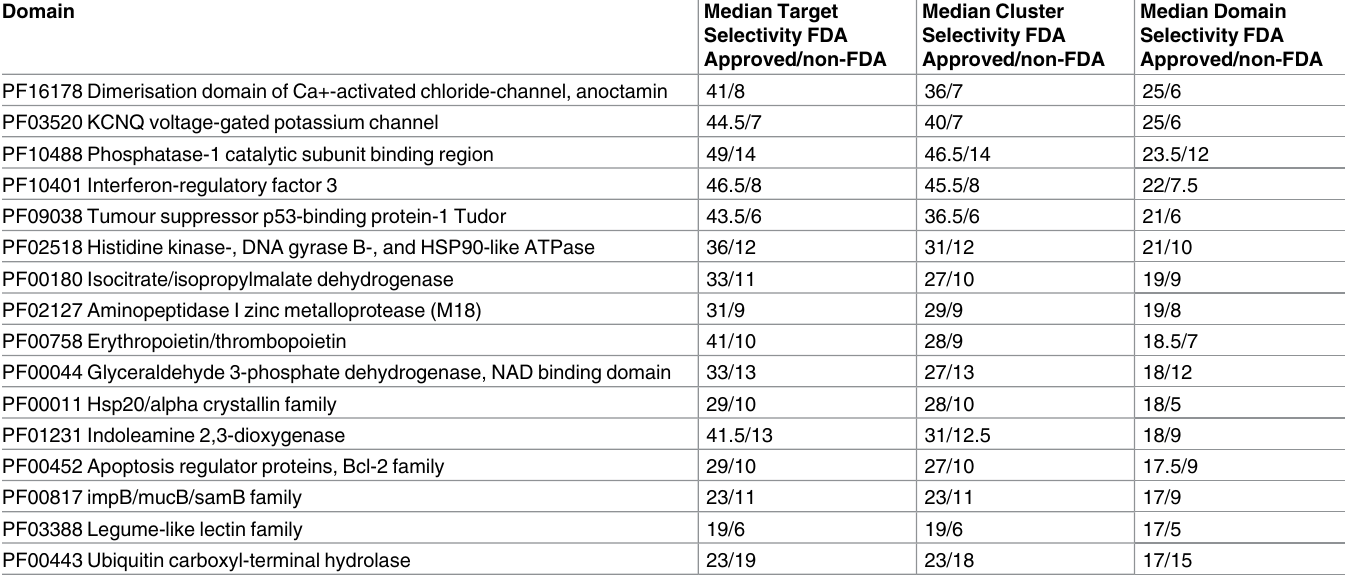
Table 4. Top 16 pfam domains with least selectiveactive drugs. Only domainspresent in the H. sapiens proteome are shown,and are sorted andselected by decreasing domainselectivity amongFDA approveddrugs. We also excludeddomainswith under 100 amino acid residues in the homology model, to avoid small repeats and domainsunlikely to be drug targets. Additionally,we report for multi-domain clusters only the most frequent and functionally descrip- tive members as outlinedin the Methodssection (see “De-duplication of SingleDomainClusters”), and also removeddomainsof unknownfunction (DUFs). To the left of the slash in each column is the median target selectivity of FDA approvedcompoundsactive against this domain, and to the right is the median selectivity of non-FDA compounds. Selectivity is quantifiedby three methods of increasinglygroupedprotein targets as describedin the text. For example,the non-FDA approvedcompoundsactive againsttargets with the PF00183 domain are active againsta median of 12 targets with distinct GenBank identifiers,so this domainhas a 12 after the slash in the first